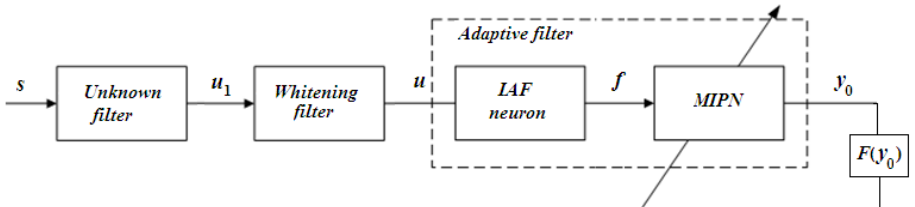
Fig. 3. The MIPN training scheme for solving the blind deconvolution